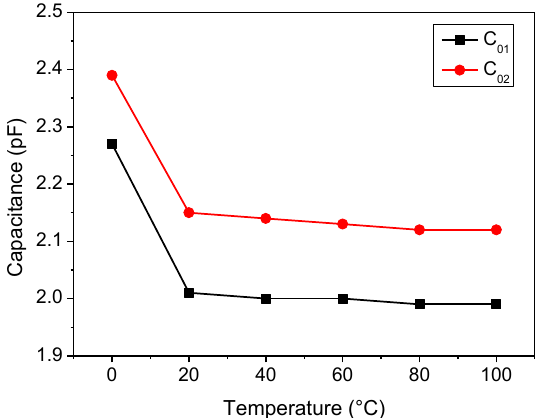
Figure 14. Temperature dependence of the input and output shunt static capacitances.